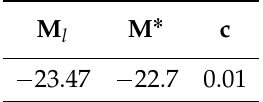
0.4 and ∆ z = 0.05. Parameters (cid:16) 0.01. (cid:16)